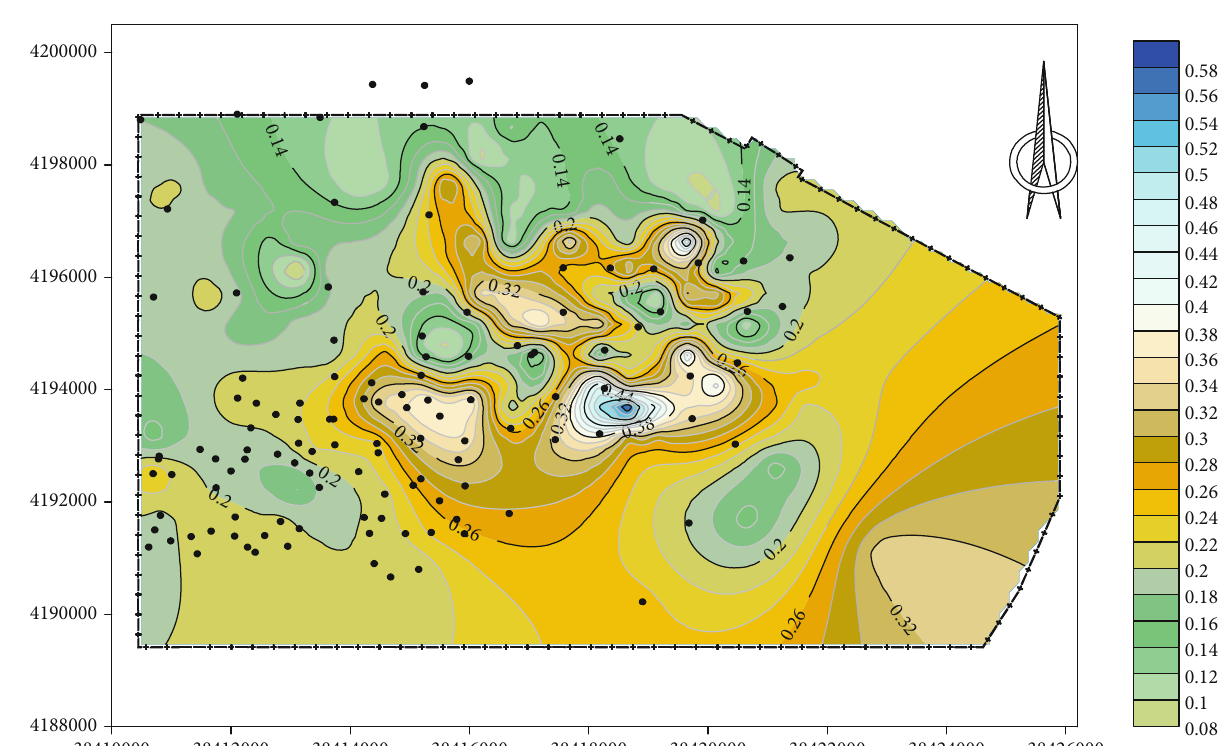
Figure 11: Multifactor superposition diagram of K